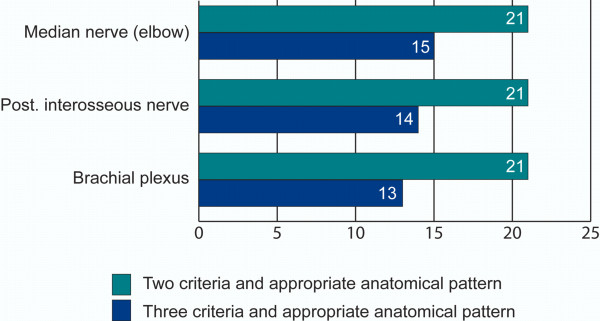
Definition according to the applied criteria of focal neuropathy in 21 dominant limbs.